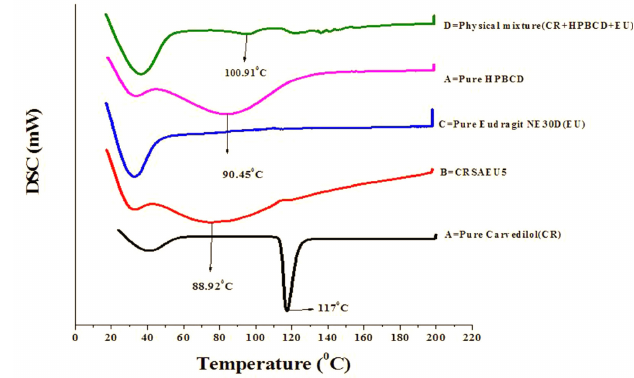
FIGURE 8 - DSC thermograms of CRSAEU5, pure carvedilol(CR), pure hydroxypropyl beta-cyclodextrin (HPBCD), physical mixture (CR+HPBCD+EU) and pure Eudragit